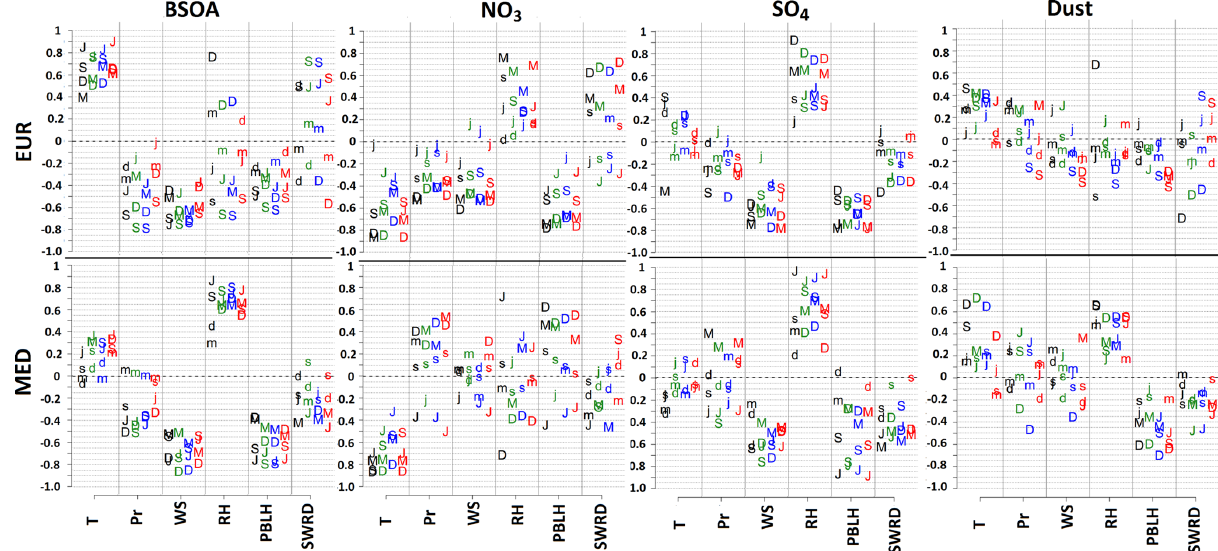
Figure 10. Correlation coefficient between all meteorological parameters tested and BSOA, (NO 3 ), sulfate (SO − 2 seasons and the EUR and MED subdomains. D, M, J and S represent winter, spring, summer and fall, respectively (first letter of the first month of each season). Uppercase letters mean that the correlation between the two parameters is statistically significant, whereas lowercase letters show the contrary. Color coding for different scenarios is the same as in previous figures.